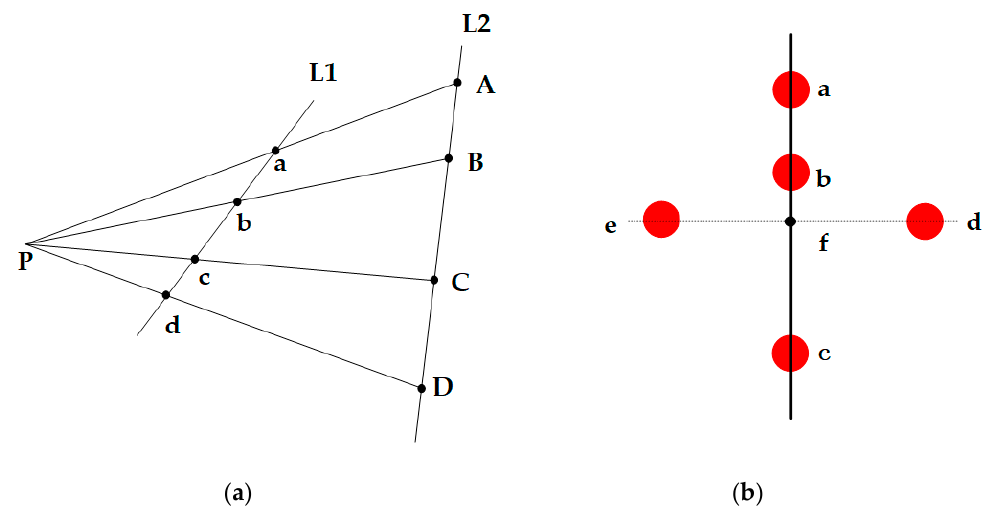
Figure 3. Structure principle of base points. ( a ) Invariant of cross-ratio. ( b ) Local coordinate system of color encoded target pattern.